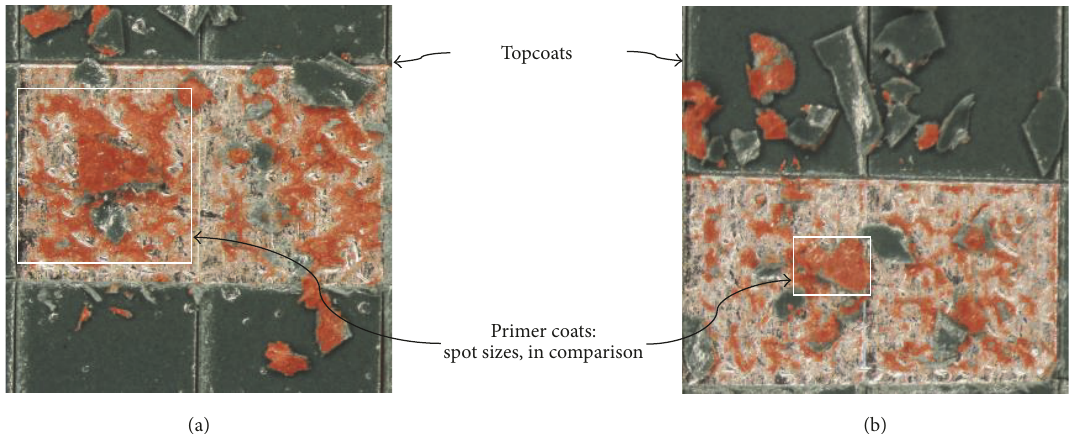
Figure 8: Micrographic test. Comparative cohesion of the PCSs when using (a) the primer and finish paint (topcoat) with the CNPS and (b) the same materials with the PNPS. The cross-cut mesh is 0.7 × 0.7 mm.